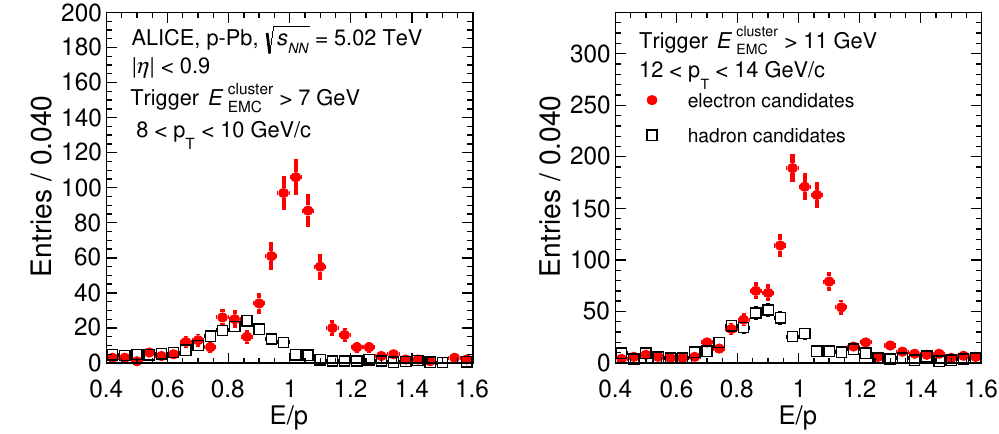
Figure 3 . E=p distribution for integrated centrality for 8 < p T < 10 GeV =c for the lower EMCal threshold triggered events (left) and for 12 < p T < 14 GeV =c for the higher EMCal threshold triggered events (right). The distributions are shown for electron candidates selected by the